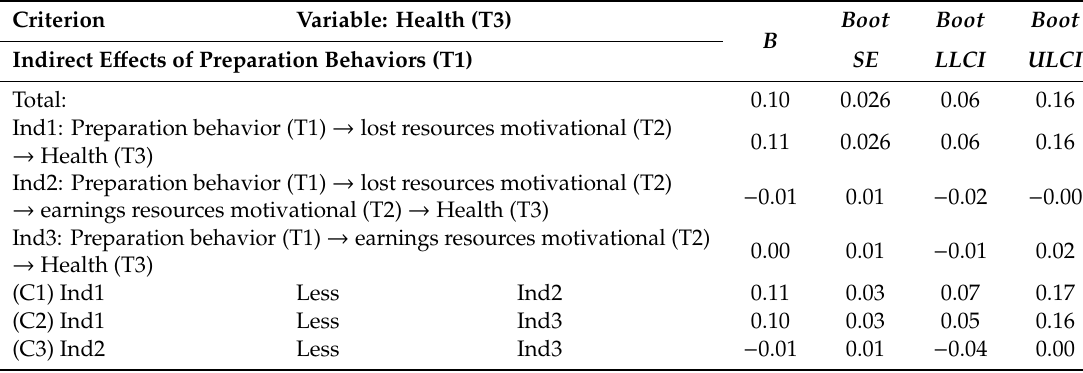
Table 10. Comparison of the indirect effects of preparation behaviors (T1) through losses (T2) and gains of motivational resource gains (T2) in the prediction of health (T3).